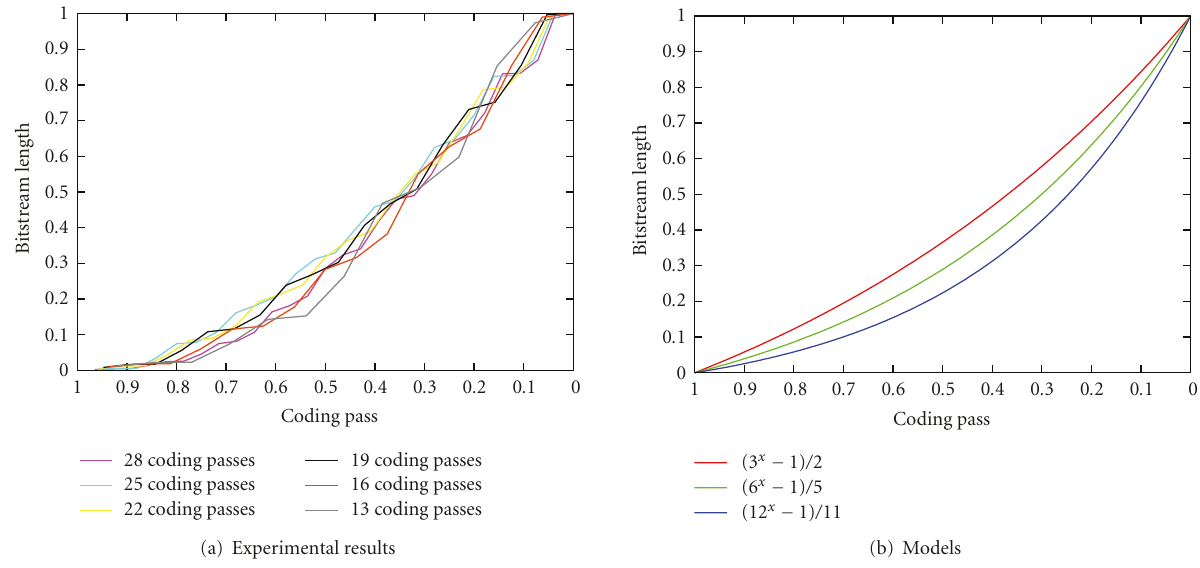
Figure 2: (a) Experimental results depicting coding passes lengths (normalized to the nominal range) generated for codeblocks of the “Portrait” image (8-bit gray-scale, size 2048 × 2560), grouping those codeblocks with the same number of coding passes. Coding parameters are: JPEG2000 lossy mode, 5 DWT levels, codeblock size 64 × 64. (b) Models to estimate coding passes lengths of